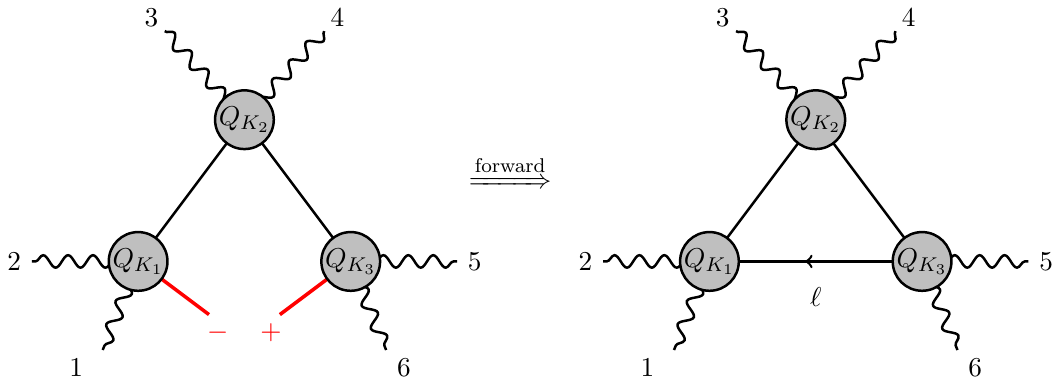
Figure 4 . Triangle diagram arises from gluing an eight-point tree diagram, where the s 12 n +1 and s 56 n +2 channels give rise to the linear propagators in the (cid:12)rst term of (4.17). The other two terms correspond to identifying the other two internal lines in the diagram with loop